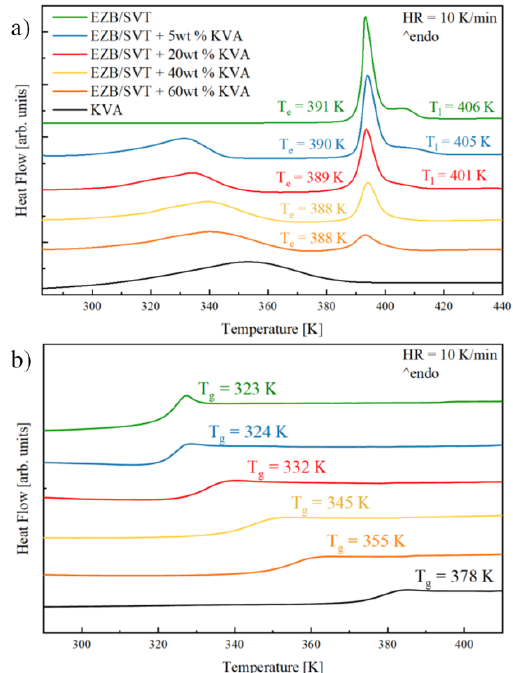
Figure 4. DSC thermograms of ( a ) crystalline and ( b ) amorphous EZB/SVT ( green lines), EZB/SVT + 5wt. % (Kollidon VA64 (KVA) ( blue lines), EZB/SVT + 20wt. % KVA ( red lines), EZB/SVT + 40wt. % KVA ( yellow lines), EZB/SVT + 60wt. % KVA ( orange lines) and KVA ( black lines).